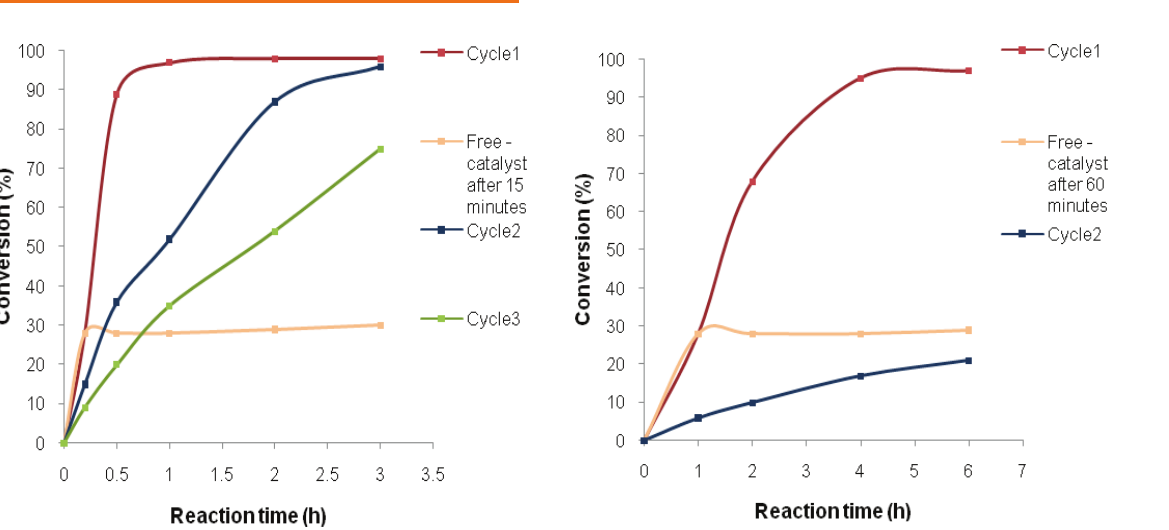
Figure 11. Kinetic curves for three recovery/reutilization cycles and the effect of the SiW leaching for H catalyst ( α -pinene/catalyst ratio of 100/1, at 160°C).